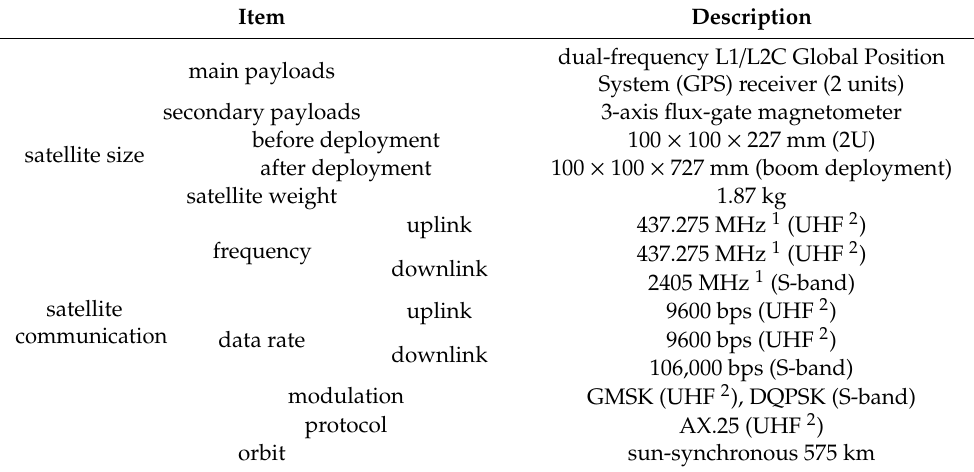
Table 1. Specifications of SNUGLITE.